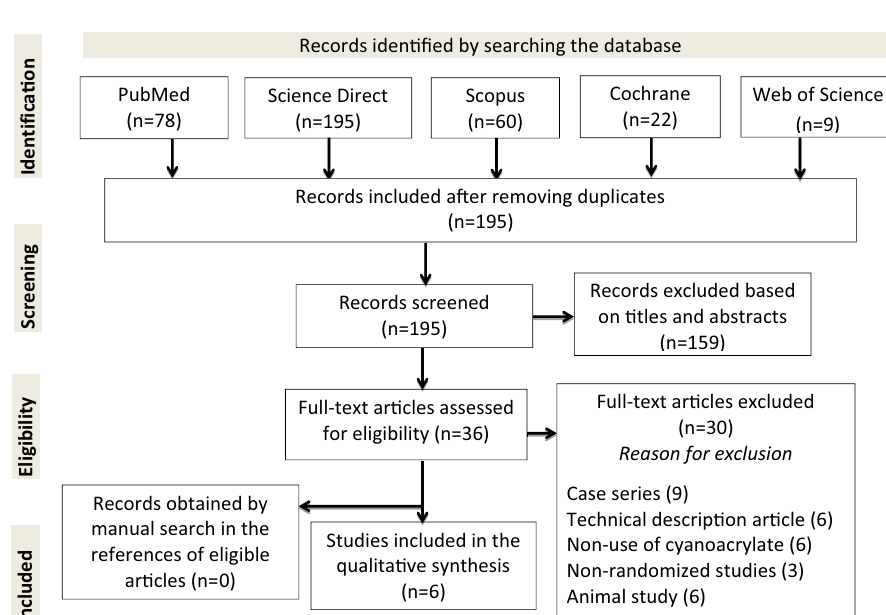
Fig. 1 PRISMA fl owchart of the study selection process. Records identi fi ed by searching the